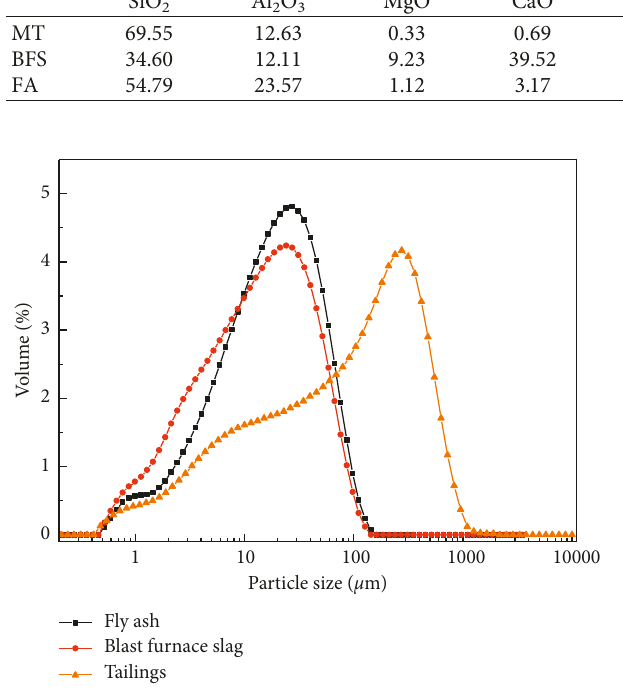
Figure 1: Particle-size distribution of tailings BFS and FA.